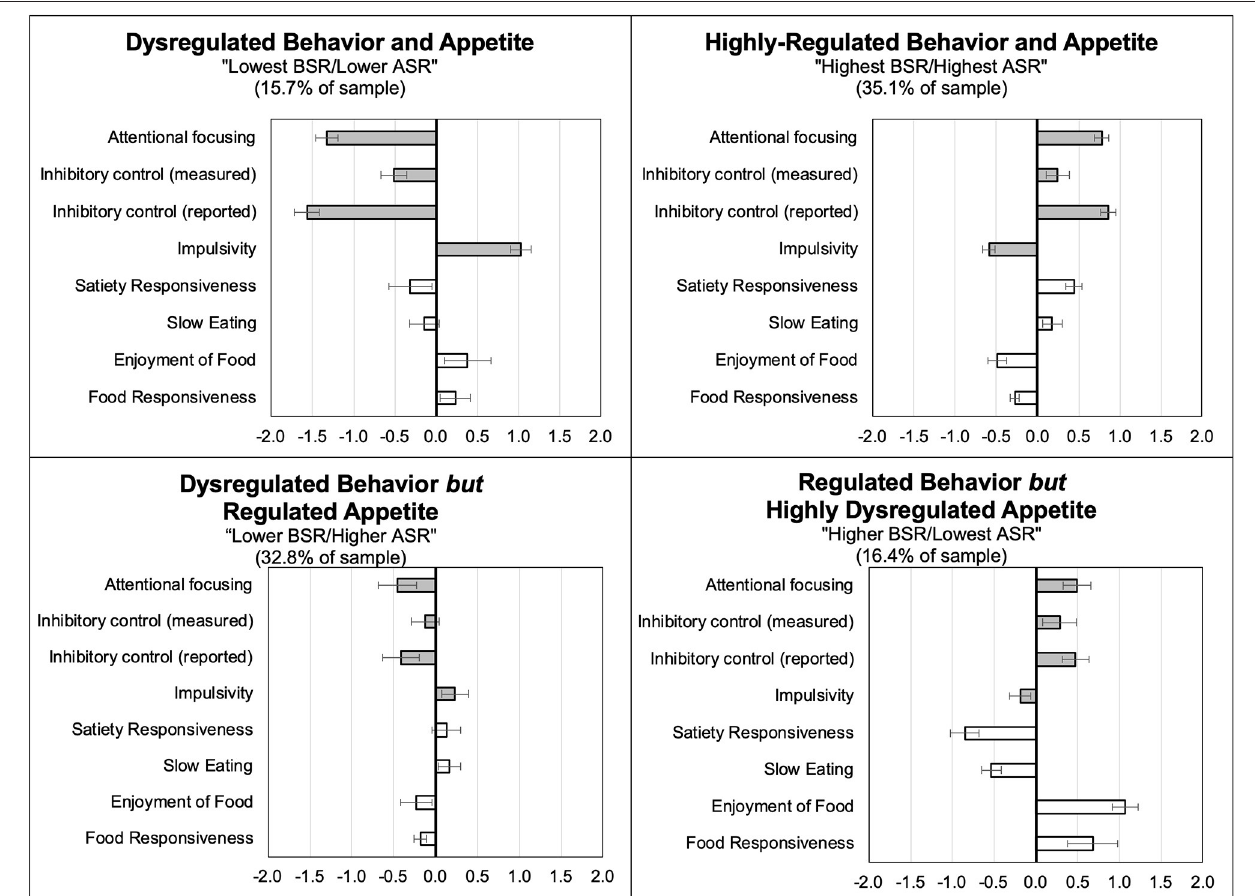
FIGURE 1 | Distribution of standardized behavioral self-regulation indices (BSR; shaded bars) and appetitive traits that contribute to appetite self-regulation (ASR; white bars) by profile membership.